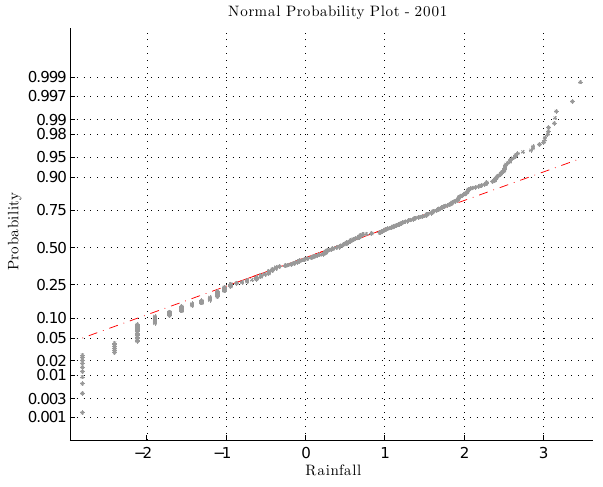
Figure 3. Lognormal test of TRMM data for 15 April